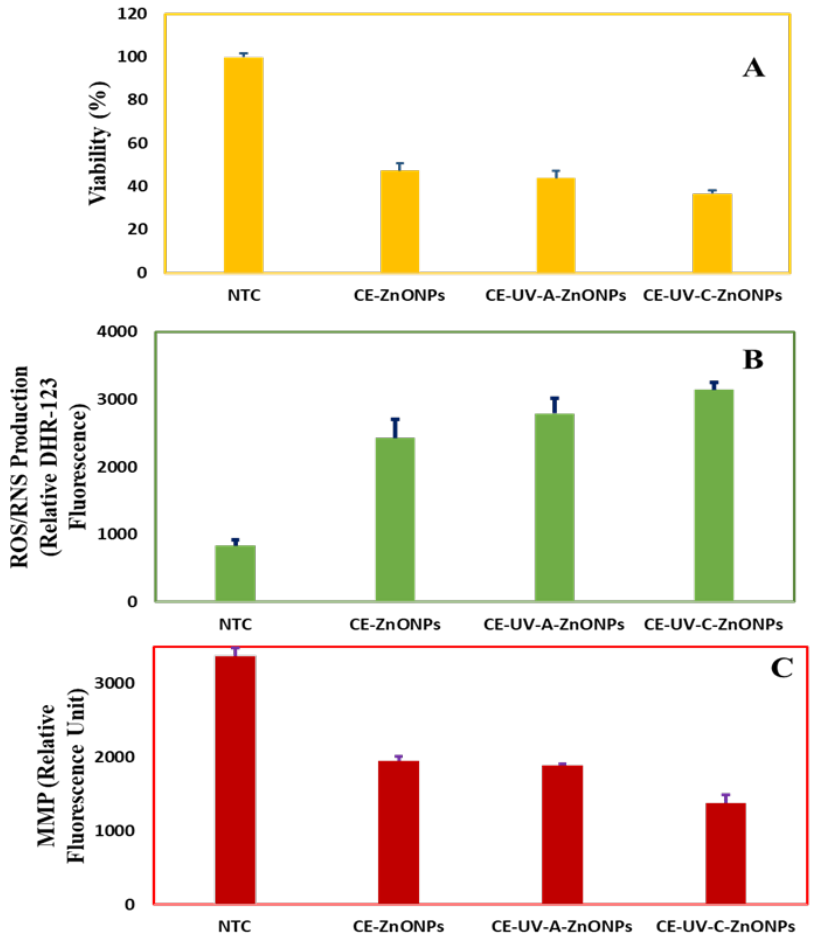
Figure 7. Anti-cancerous activities of ZnONPs ( A ) Measurement of HepG2 cell viability ( B ) Produc- tion of ROS/RNS ( C ) Measurement of mitochondrial membrane potential of HepG2 cells in response to green-synthesized-ZnONP treatment.